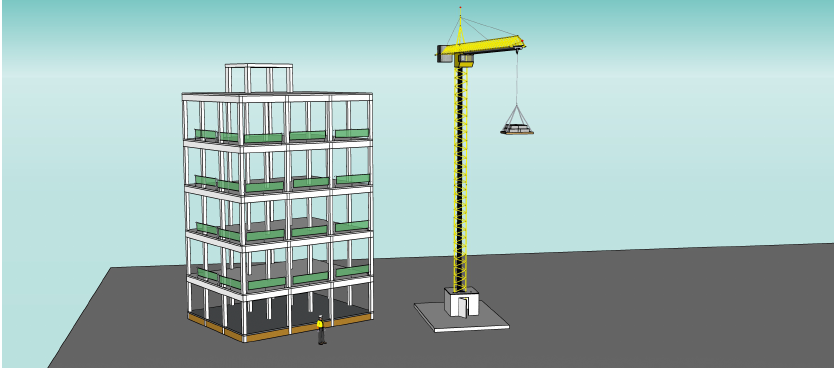
Figure 5. Visual example of material loading tasks: Medium risk. Listing 4. Case 2: Results provided by the IOT-JFML system for the scenario 2 (medium risk).